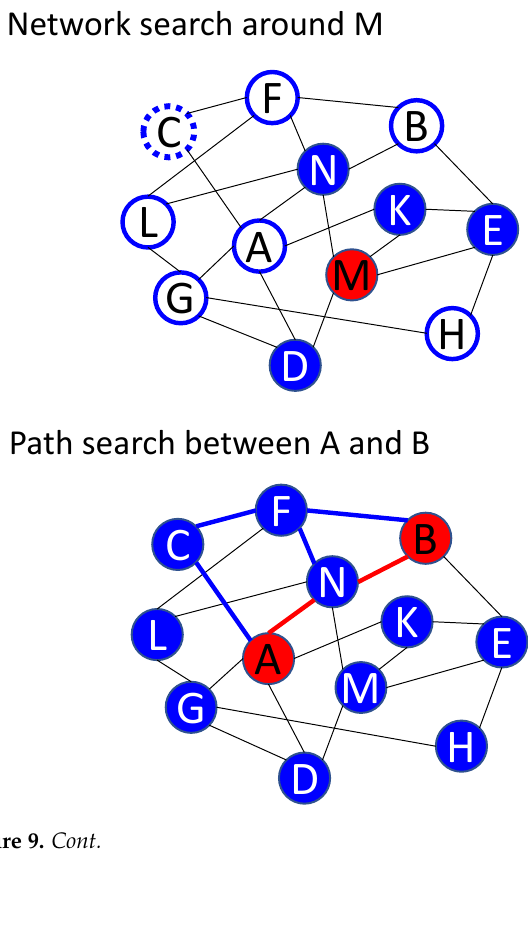
Figure 9 . Two basic searches ( a ) network search and ( b ) path search, and search for avoiding trade- offs ( c ), which can be realized by combining path search and network search. 4. Computer Systems Although the small system shown in Figure 7 has been developed and demonstrated [16,17,40], the number of material properties and relationships stored in the system is quite limited because the relationships between material properties were extracted man- ually. Computer technology for automated relationship extraction is essential for practical use. The author has collaborated with a company to realize automated relationship ex- traction from several textbooks on materials science, and a prototype system has been developed as a result of this collaborative project [41]. The relationships between material properties automatically extracted from the 12 textbooks listed in Table 1 are currently included in the web-based system. Figure 10 shows an example of the system output for a path search (Figure 9b) between work function and Vickers hardness, whose